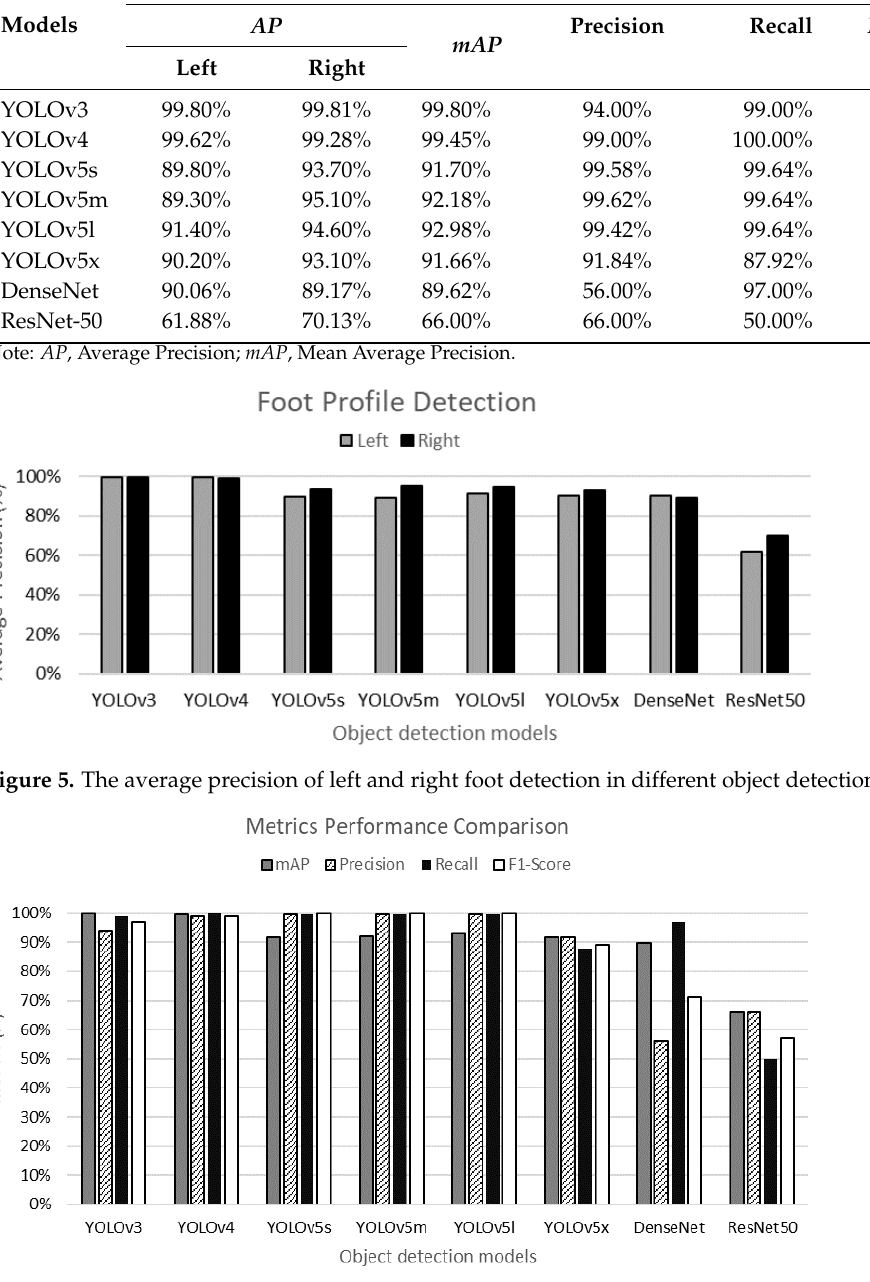
Figure 6. YOLO series comparison results in various metrics. YOLOv4 exhibits persistent accuracy gains across various metrics. gains across various